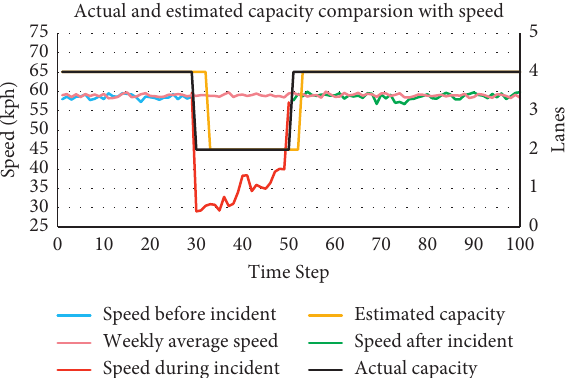
Figure 12: Comparison of estimated capacity with actual